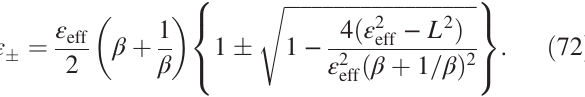
FIG. 11. Transport of the magnetized beam to the cooler. The ERL mostly consists of an axisymmetric accelerating field and is a rotationally invariant, decoupled beam